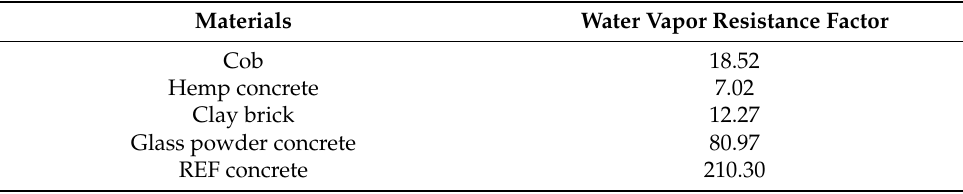
Figure 16. Comparison of water vapor permeability of concrete, glass powder concrete, hemp concrete, clay brick, and raw earth/straw (RES). Table 1. Water vapor resistance factor of concrete, glass powder concrete, hemp concrete, clay brick, and